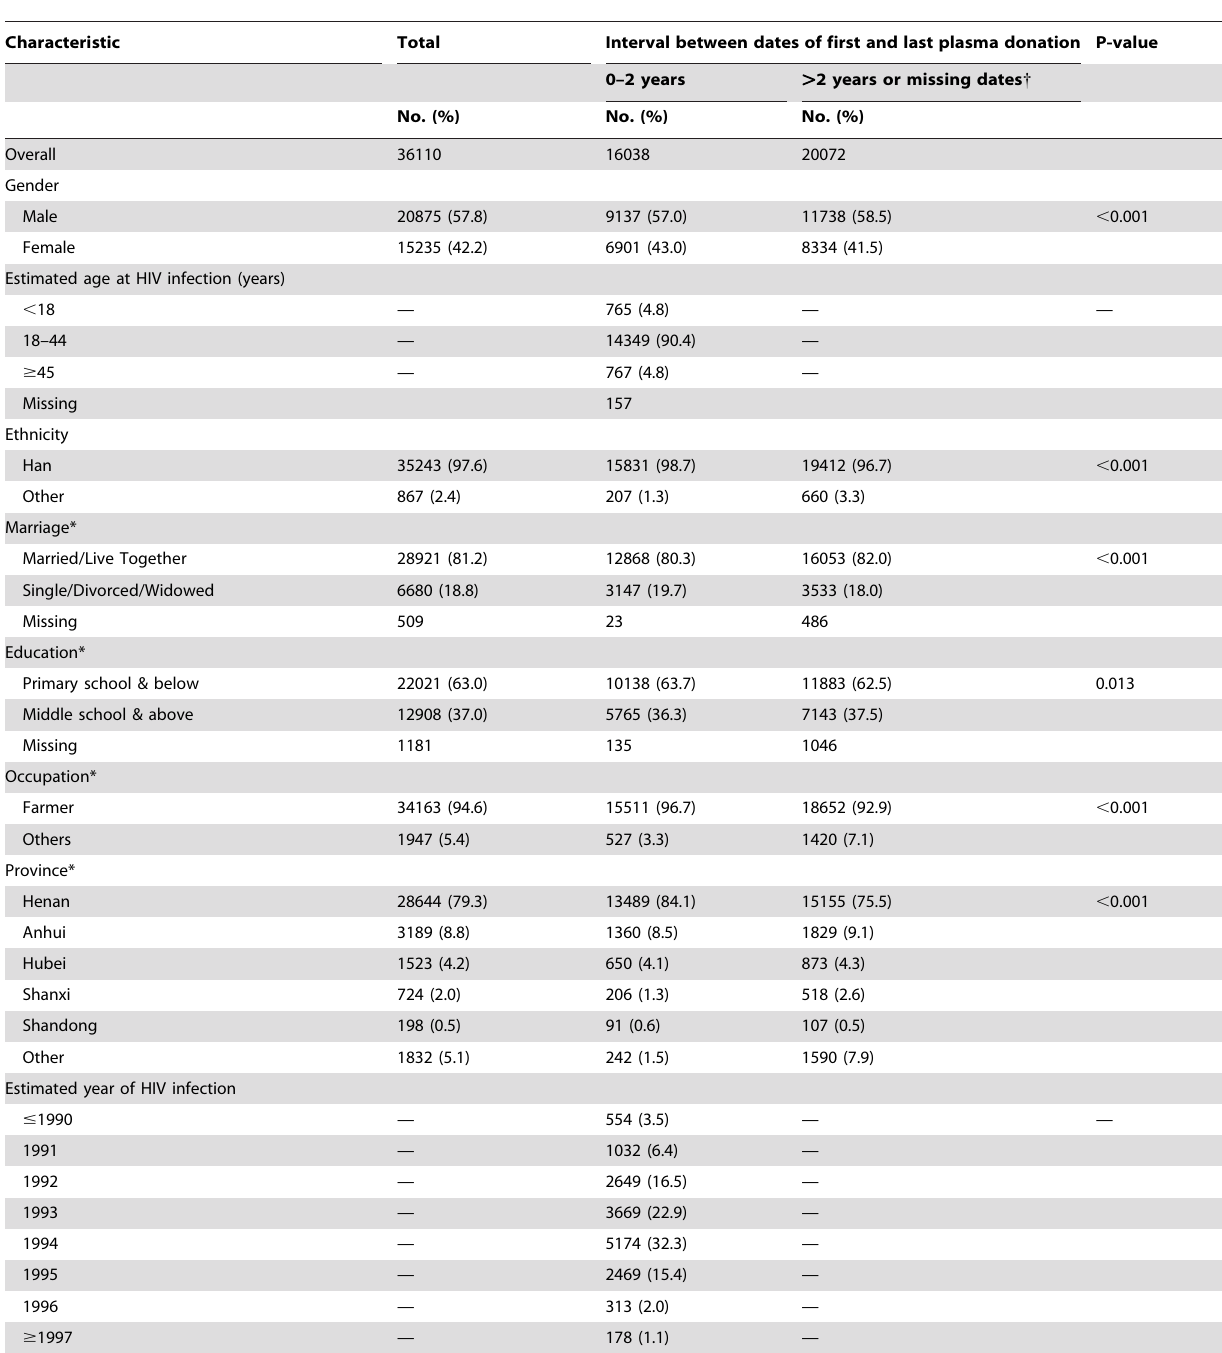
Table 1. Characteristics of the 36110 former plasma donors included in the analysis from 1985–2008, stratified by plasma donation window # 2 years vs. . 2